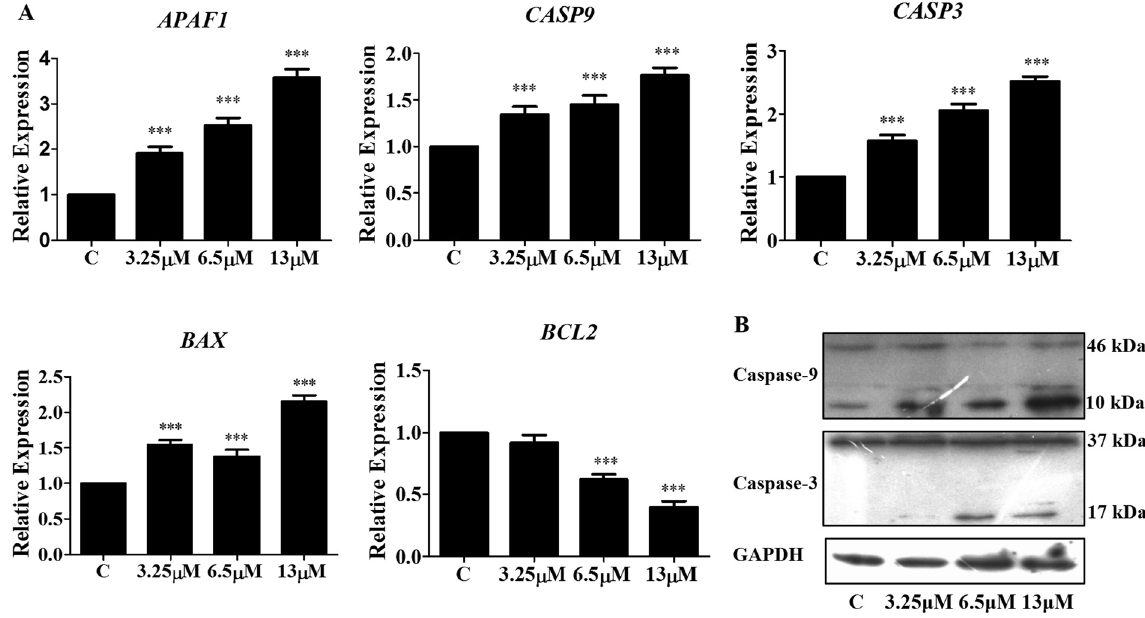
Figure 6. Effect of M22 on apoptosis related genes and proteins in A549 cells. ( A ) M22 upregulated the expression of proapoptotic genes APAF1 , CASP9 , CASP3 , BAX , and depress antiapoptotic genes BCL2 for 48 h. RNA was isolated and analysis was performed to detect by qRT-PCR. * Means P < 0.01, *** means P < 0.0001. ( B ) Western blot analysis showed cleavage of caspases-9 and − 3 in M19 treated A549 cells after 48 h of exposure. Equal loading was confirmed by reprobing the membrane with GAPDH. The bands shown here are from a representative experiment repeated three times with similar results.